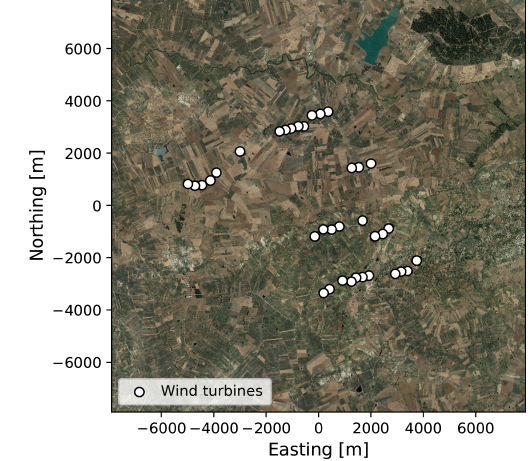
Figure 9. The aerial image of the Italian site. Aerial data: © Google Maps, DigitalGlobe.